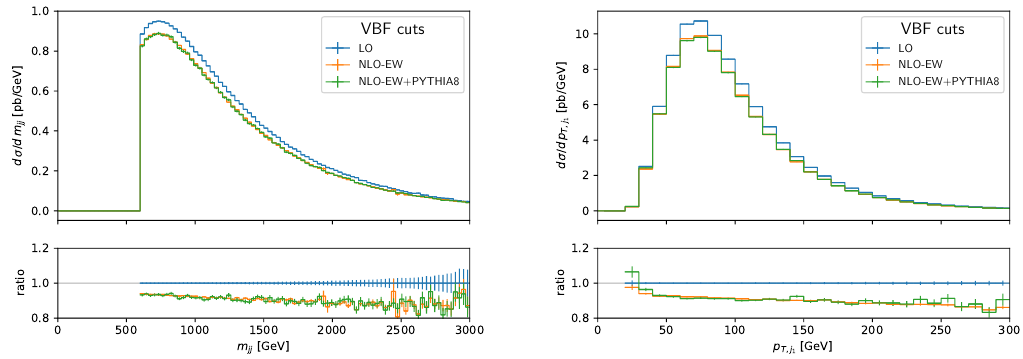
Figure 6 . Invariant-mass distribution of the two tagging jets (left) and transverse-momentum distribution of the hardest tagging jet (right) at LO (blue), NLO-EW (red), and NLO-EW+PS (green) accuracy within the VBF cuts of eqs. (3.5)–(3.8). The ratios of the NLO-EW+PS and the NLO-EW to the LO results are shown in the respective lower